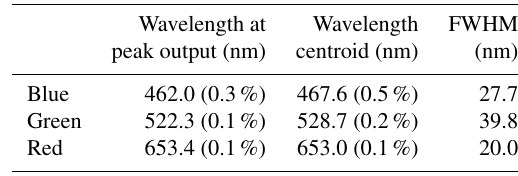
Table 1. Spectral output characteristics of the light source. Values in parentheses are the coefficients of variation of measurements on 31 light sources. FWHM denotes the width of the curves at half the peak